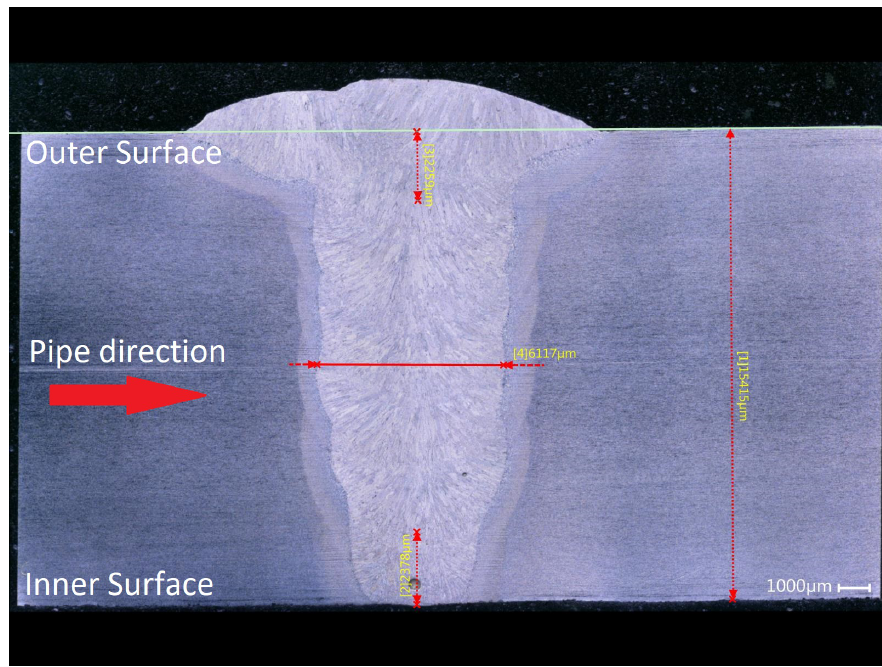
Figure 1. Weld macro overview of the girth weld including measurements of the wall thickness, weld thickness and thicknesses of the first and last weld passes.